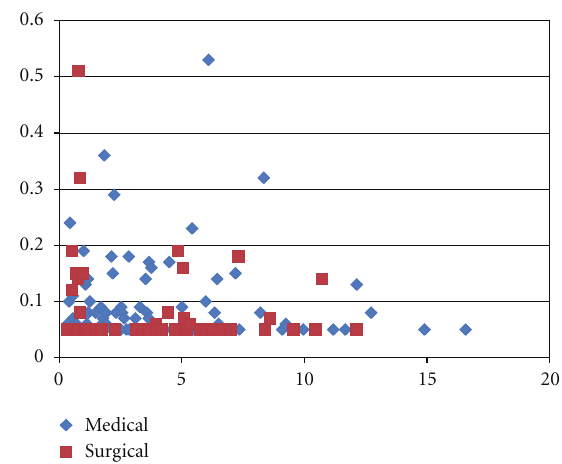
Figure 1: Serum testosterone levels in prostate cancer patients continuously on LHRH agonist or surgical castration. Medical: LHRH agonist, Surgical: surgical castration, vertical line: serum testosterone level (ng/mL), horizontal line: time after induction of LHRH agonist/surgical castration (years).